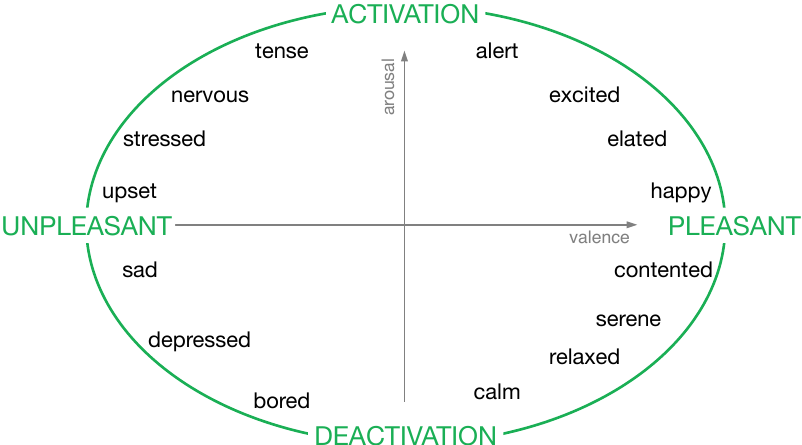
Figure 2. Graphical representation of the Russell’s circumplex model of affect: valence is reported in the horizontal axis (ranging from totally unpleasant to fully pleasant), while arousal is reported on the vertical